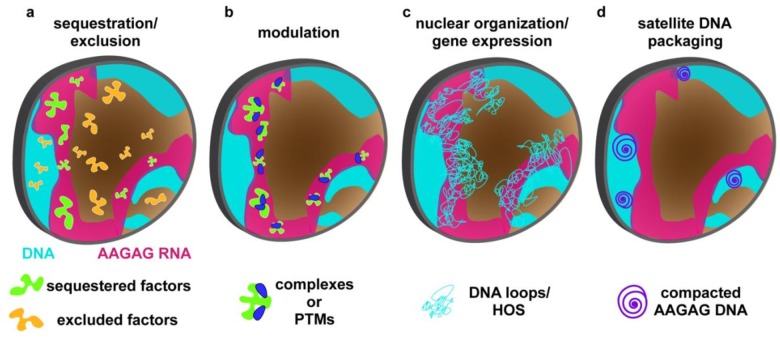
Model for AAGAG RNA function during spermatogenesis.AAGAG RNA (magenta) present only in primary spermatocytes (light blue = chromosome territories) acts directly or indirectly to promote important processes later in sperm maturation, including the histone-protamine transition and individualization. AAGAG RNA could ensure normal completion of later events by mediating: (a) proper localization of factors (RNA and/or protein) through sequestration (green) or exclusion (orange), (b) formation of molecular complexes or modifications (e.g. PTMs) (green blobs plus blue ovals), (c) regulation of global DNA/chromatin organization (e.g. condensation, Y loops, Higher Order Structures (HOS)) which for example could impact expression of critical spermatogenesis genes, or (d) local DNA/chromatin organization of cognate AAGAG loci, as observed for heterochromatin recruitment by siRNAs. Although direct experiments are required to test these models, we favor d) because it can accommodate both fast turnover of satellite sequences during evolution and sequence-independent roles in ensuring fertility (see text).